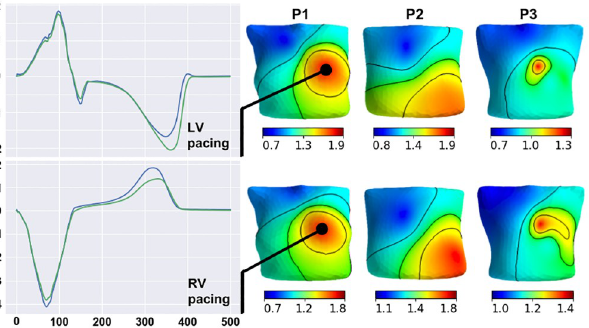
Fig 13. Examples of regional RED maps for the torso surface potential under variation in the transmural heterogeneity coefficient in three patient-specific models (see annotation on the top). The top row shows the pattern for LV pacing, and the bottom row shows the pattern for the RV pacing. The design of the map visualization is the same as in Figs 8–11.